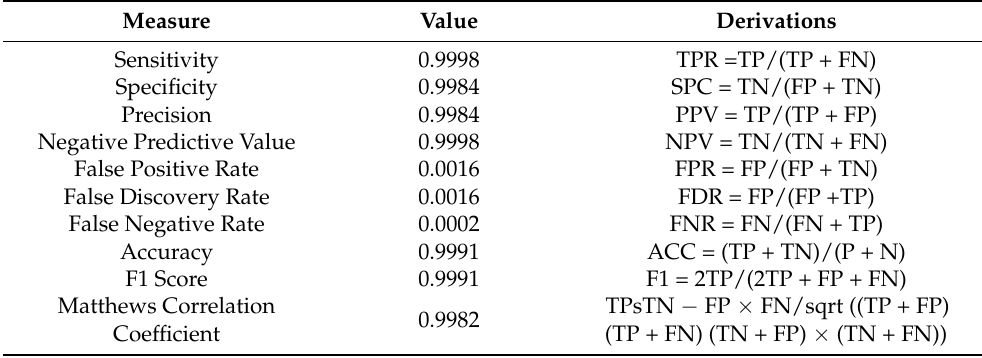
Figure 4. Accuracy analysis with various numbers of patients and locations. Table 2. Overall